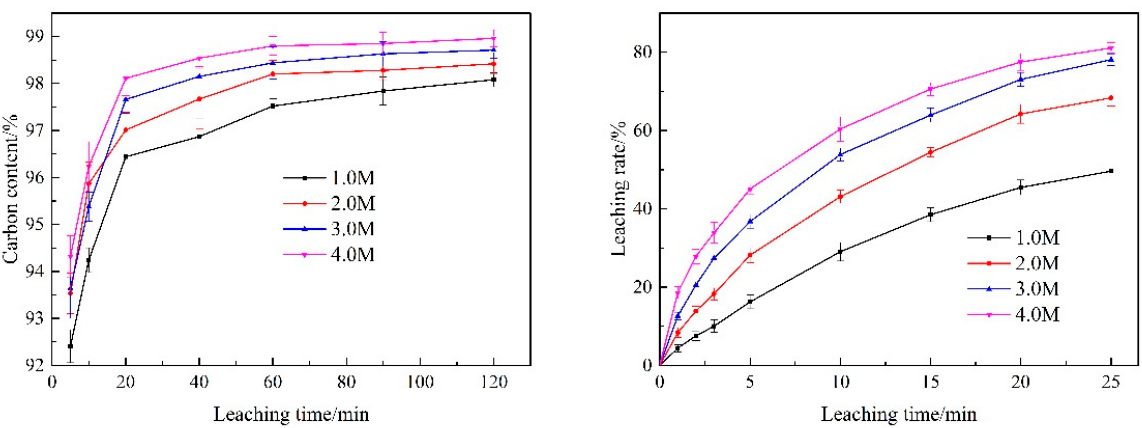
Figure 5. Effect of initial HCl concentration on carbon content ( left ) and Al leching rate ( right ) (particle size D(50) = 67.49 µ m, 333 K, NaF 0.3 mol/L).